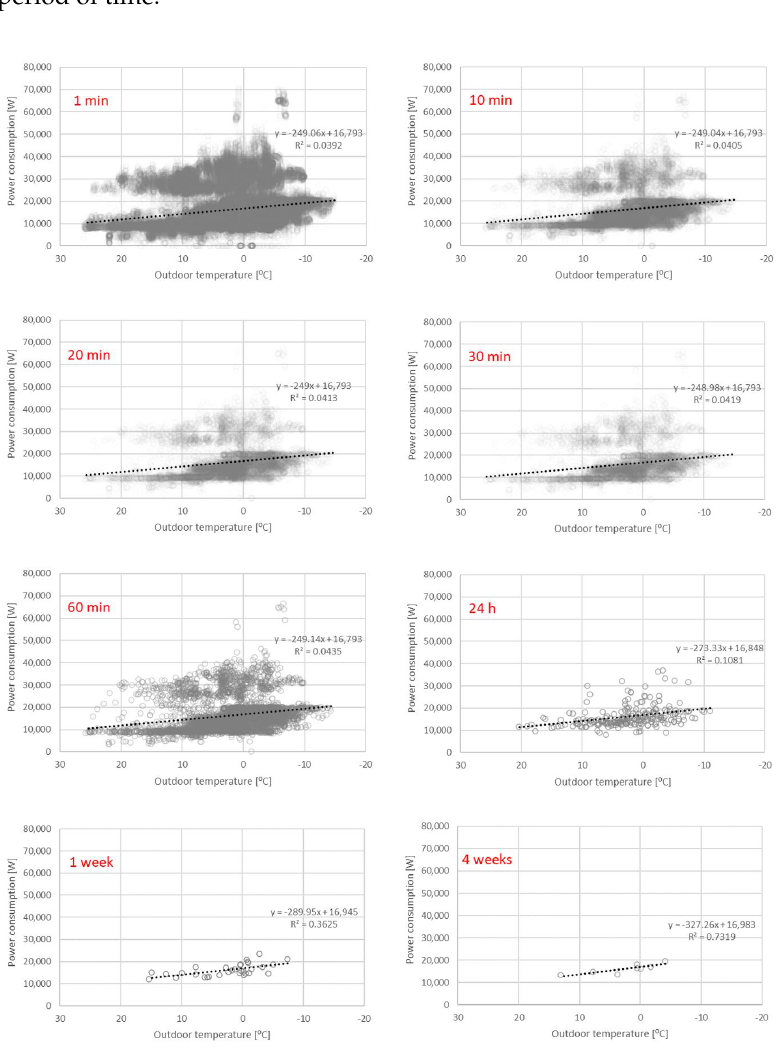
Figure 7. Averaged total power consumption plotted against averaged diurnal outdoor dry-bulb temperature when the dataset is averaged from 1 min to 4